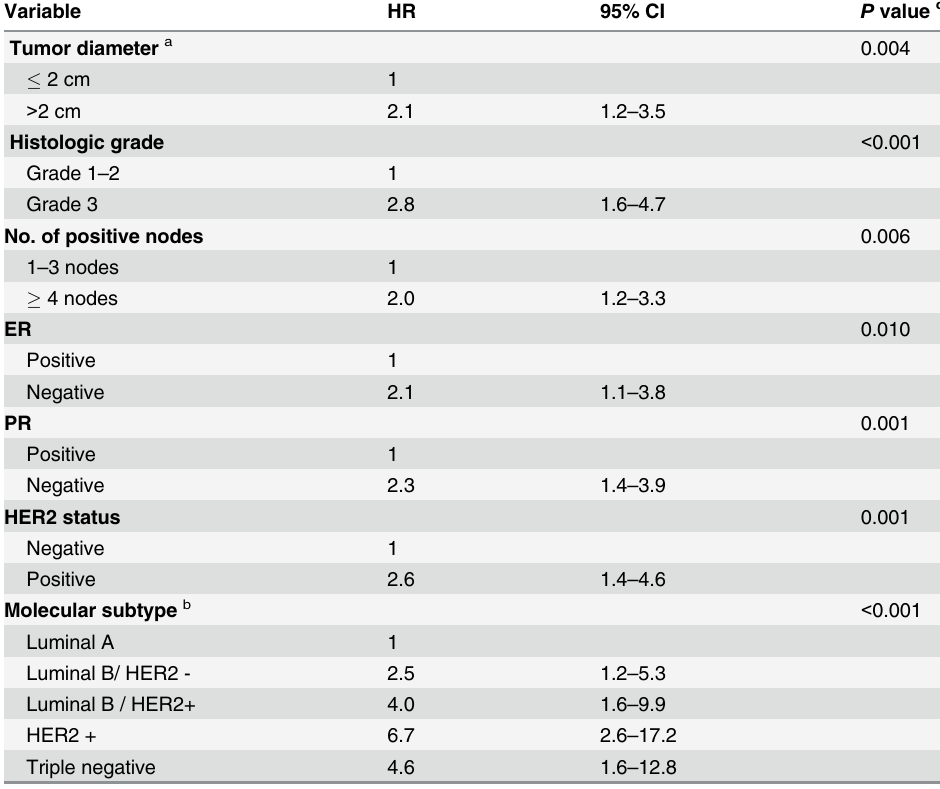
Table 3. Univariate survival analysis of features of primary tumors ( n =